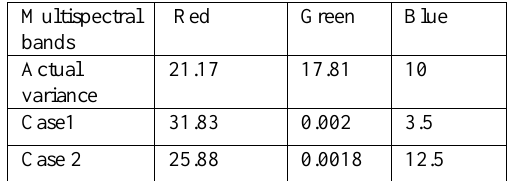
Table 3. Comparison of variance between the data for the second dataset